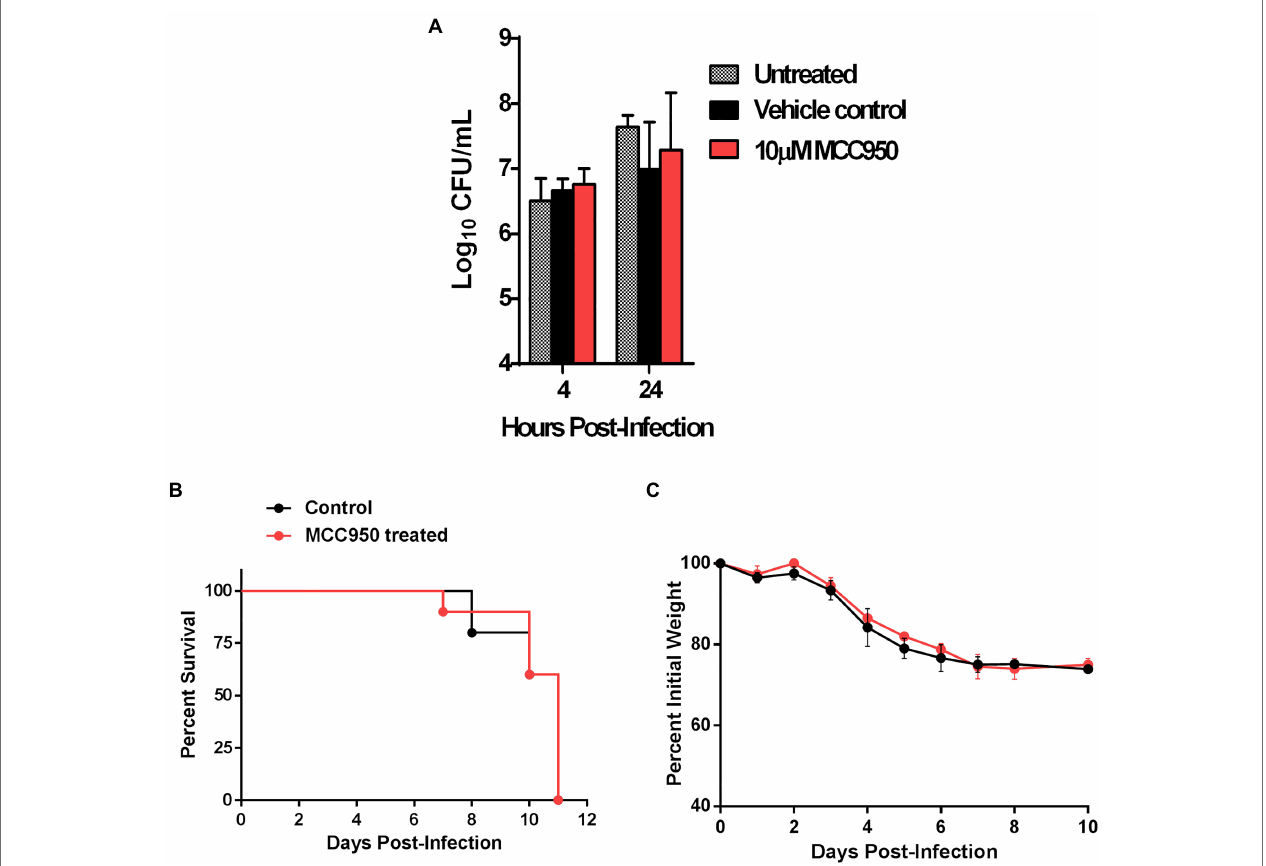
FIGURE 7 | The detrimental role of Nlrp3 is independent of its role as an inflammasome activator. (A) Primary BMDMs isolated from C57BL/6 mice were either left untreated or treated with 10 μ M of MCC950 or an equal volume of DMSO as vehicle control. The BMDMs were infected with F. tularensis LVS at an MOI of 10 and bacterial numbers were quantitated 4 and 24 h post-infection. The results are expressed as Log 10 CFU/ml and are cumulative of two independent experiments each conducted with 2–3 biological replicates ( n = 5 total). C57BL/6 mice ( n = 10) were injected intraperitoneally (i.p.) with MCC950 (10 mg/kg body weight) for six consecutive days. The control mice ( n = 10) were injected i.p. with an equal volume of DMSO as vehicle controls. All mice were infected i.n. with 1.5 × 10 4 CFU of F. tularensis LVS and were observed for survival and weight loss. Survival results are plotted as Kaplan-Meir survival curves (B) and the body weights are represented as percent initial body weight (C)